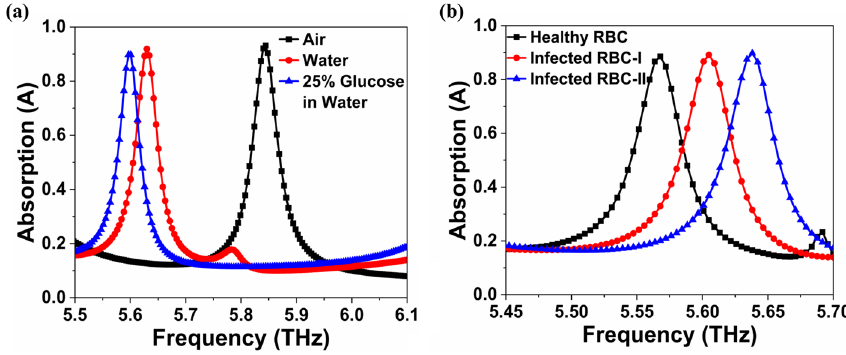
Figure 8. Effect on absorption response with the sensing of ( a ) Glucose and ( b )